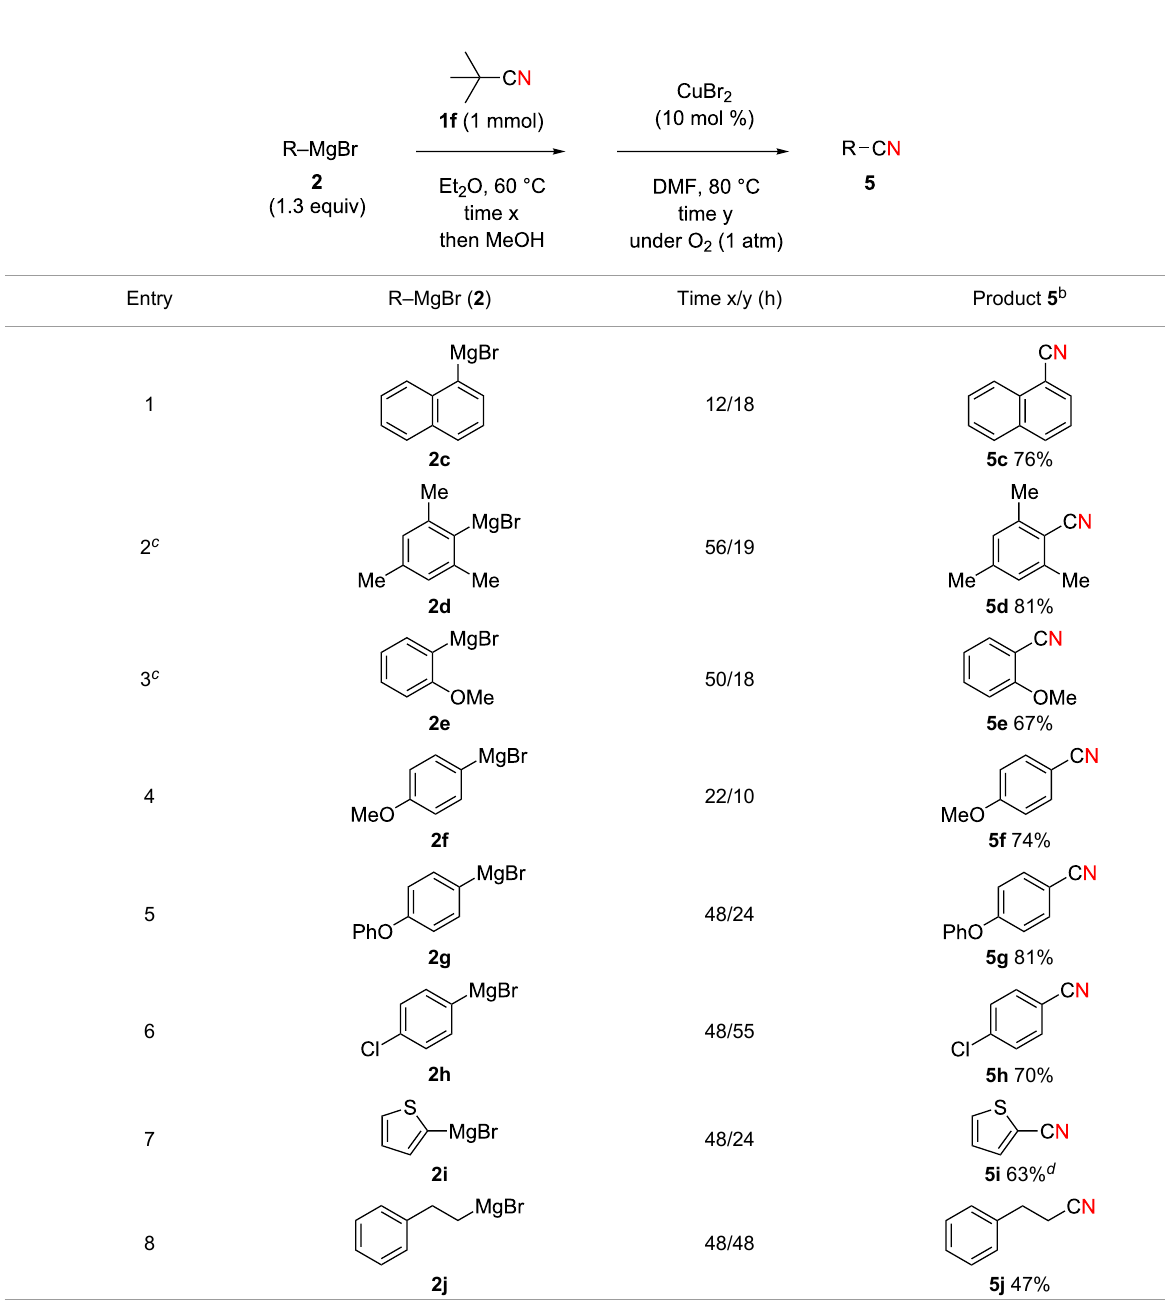
Table 3: Scope of the reaction using different Grignard reagents.